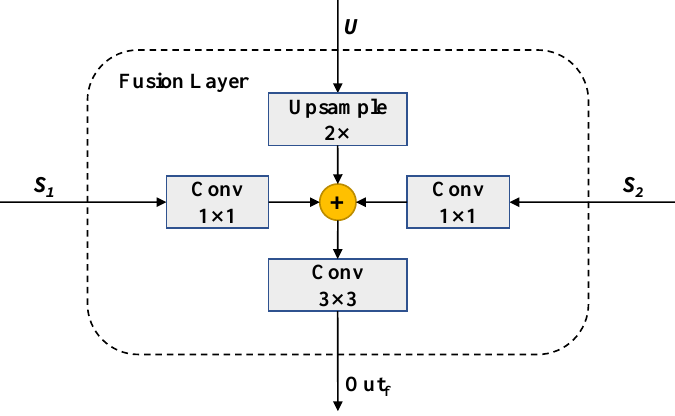
Figure 5. The structure of a fusion layer. If it is the top layer, U is not included. The specific fusion output function is shown below: